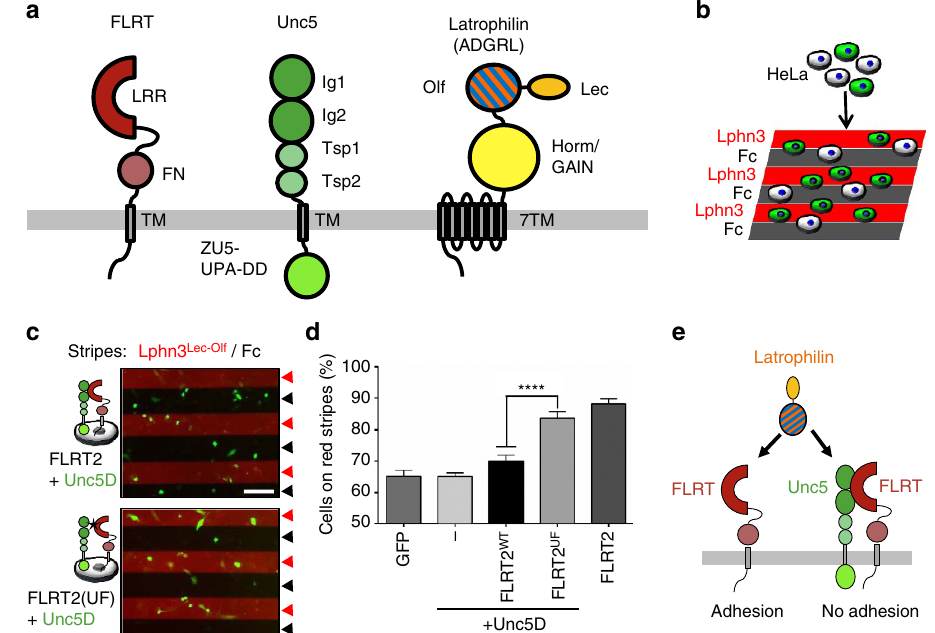
Figure 1 | Unc5D attenuates Lphn3-FLRT2-mediated adhesion. ( a ) The domain composition of FLRTproteins, Unc5 receptors and Latrophilins is highly conserved across vertebrates. Domains are coloured according to protein type: FLRT (reds); Unc5 (greens); and Latrophilin (yellow/orange or blue). Linkers of unknown fold are shown as black lines. ( b ) We performed stripe assays in which transfected HeLa cells were seeded on alternating stripes of Lphn3 protein or control Fc protein. ( c ) Stripe assays in which HeLa cells (green) expressing GFP control, Unc5D alone, FLRT2 alone, FLRT2 þ Unc5D or FLRT2(UF) þ Unc5D were seeded on alternating stripes of Lphn3 Lec–Olf (red arrowheads) or control Fc protein (black arrowheads). FLRT2(UF) is a FLRT2 mutant that is unable to bind Unc5D via the ectodomain 5 . Scale bar, 100 m m. ( d ) The percentage of transfected cells adhering to red (Lphn3 Lec–Olf ) stripes was quantified by measuring the fraction of green pixels present on red stripes in each image. A value of 100% would represent an image where all transfected cells have adhered to red stripes. Statistical significance was determined using an unpaired, two-tailed t -test (**** P o 0.0001). Error bars represent the s.e.m. and results are averaged over seven repeat experiments performed in duplicate. ( e ) Summary cartoon showing that Latrophilin–FLRT interaction causes cell adhesion, however in cis interaction of FLRT and Unc5 attenuates Latrophilin-induced